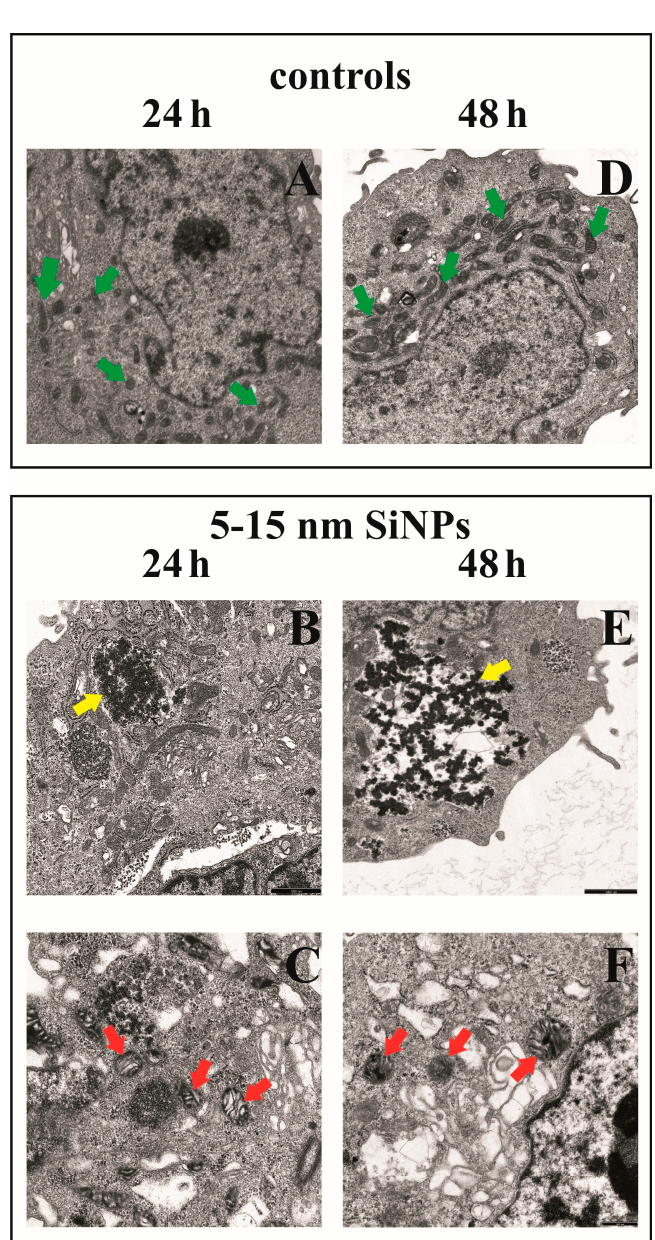
Figure 5. Morphological changes in LBC3 cells incubated with 50 μ g/mL of 5–15 nm SiNPs for 24 ( A – C ) and 48 h ( D – F ) exposure. Control cells ( A —left panel, D —right panel): numerous oval or rod-shaped mitochondria with clear intermembrane spaces were clearly visible (green arrows), (magnification 3000 × ). B —left panel and E —right panel: part of cell with electron dense regions located close to the membrane (yellow arrows), (magnification 7000×). C —left panel and F —right panel: a fragment of the cell with visible multiform mitochondria, mitochondrial swelling with firmly compacted mitochondrial matrix, bright spaces intermembrane (cristae), swelling and cristae rupturing (red arrows), are visible (magnification 12,000 × ).